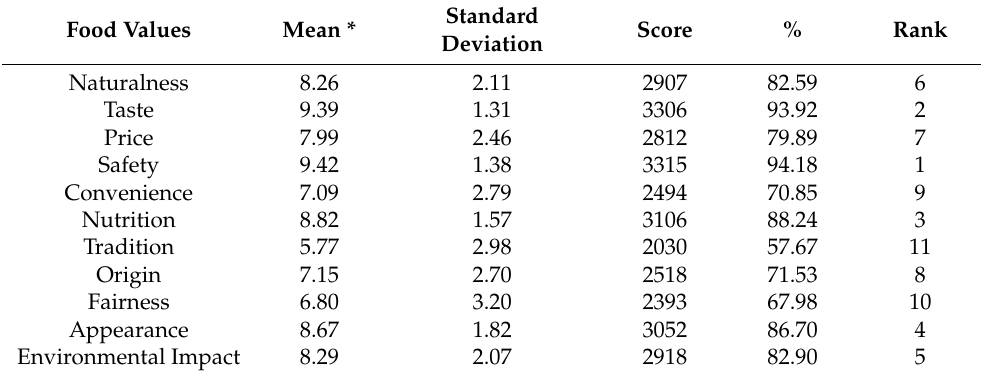
Table 1. Descriptive statistics and importance ranking for food values. Food